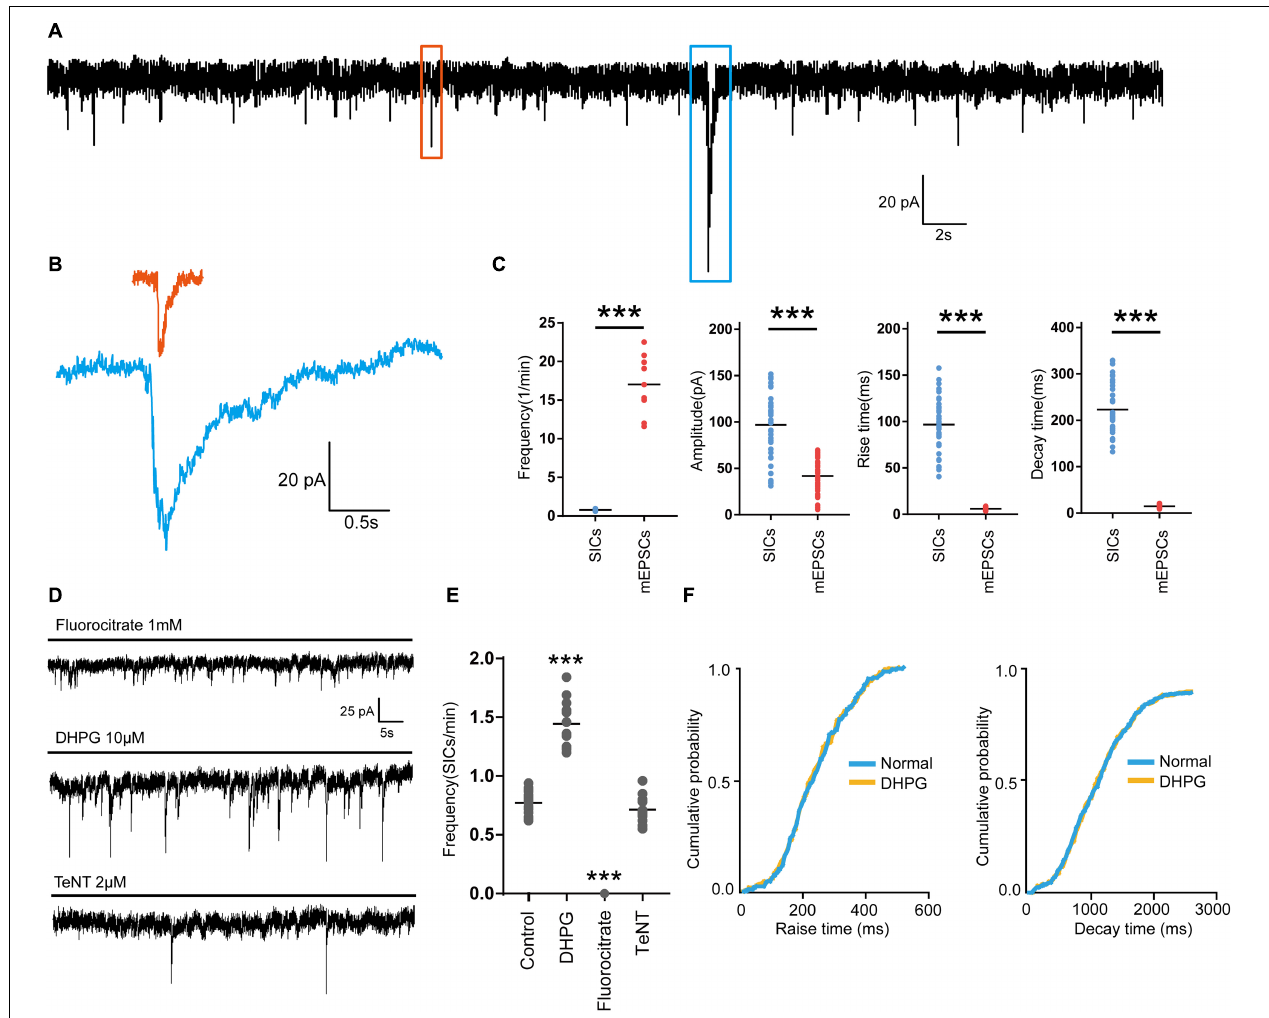
FIGURE 1 | Parameters of SICs and mEPSC from the prefrontal cortex neuron. (A) , Representative trace of SICs and mEPSCs recorded from a PFC neuron at a holding potential of –60 mV. The red square marks a mEPSC and a SIC is labeled by the blue square. (B) mEPSC (red) and SIC (blue) were showed in a larger scale. (C) Statistical summary of frequency, amplitude, rise and decay time of SICs and mEPSCs. Differences with statistically significant ( ∗∗∗ p < 0.001, compared with control) were verified by unpaired t -test. (D) Representative traces of SICs exposed to fluorocitrate, DHPG and TeNT administration. (E) Statistical summary of frequency of SICs recorded in 10 min before and after fluorocitrate, DHPG and TeNT administration. (F) Cumulative probability curves for SIC rise times and decay times for normal (blue line) and DHPG treatment (yellow line), no statistical difference, Kolmogorov-Smirnov test. Data were presented as mean ± SD. Dots represent individual